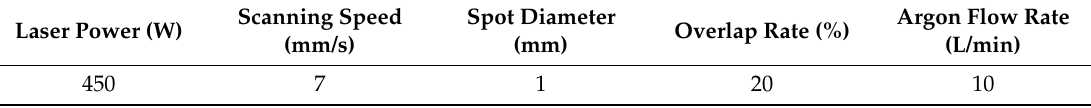
Table 3. The selected parameters for the laser cladding